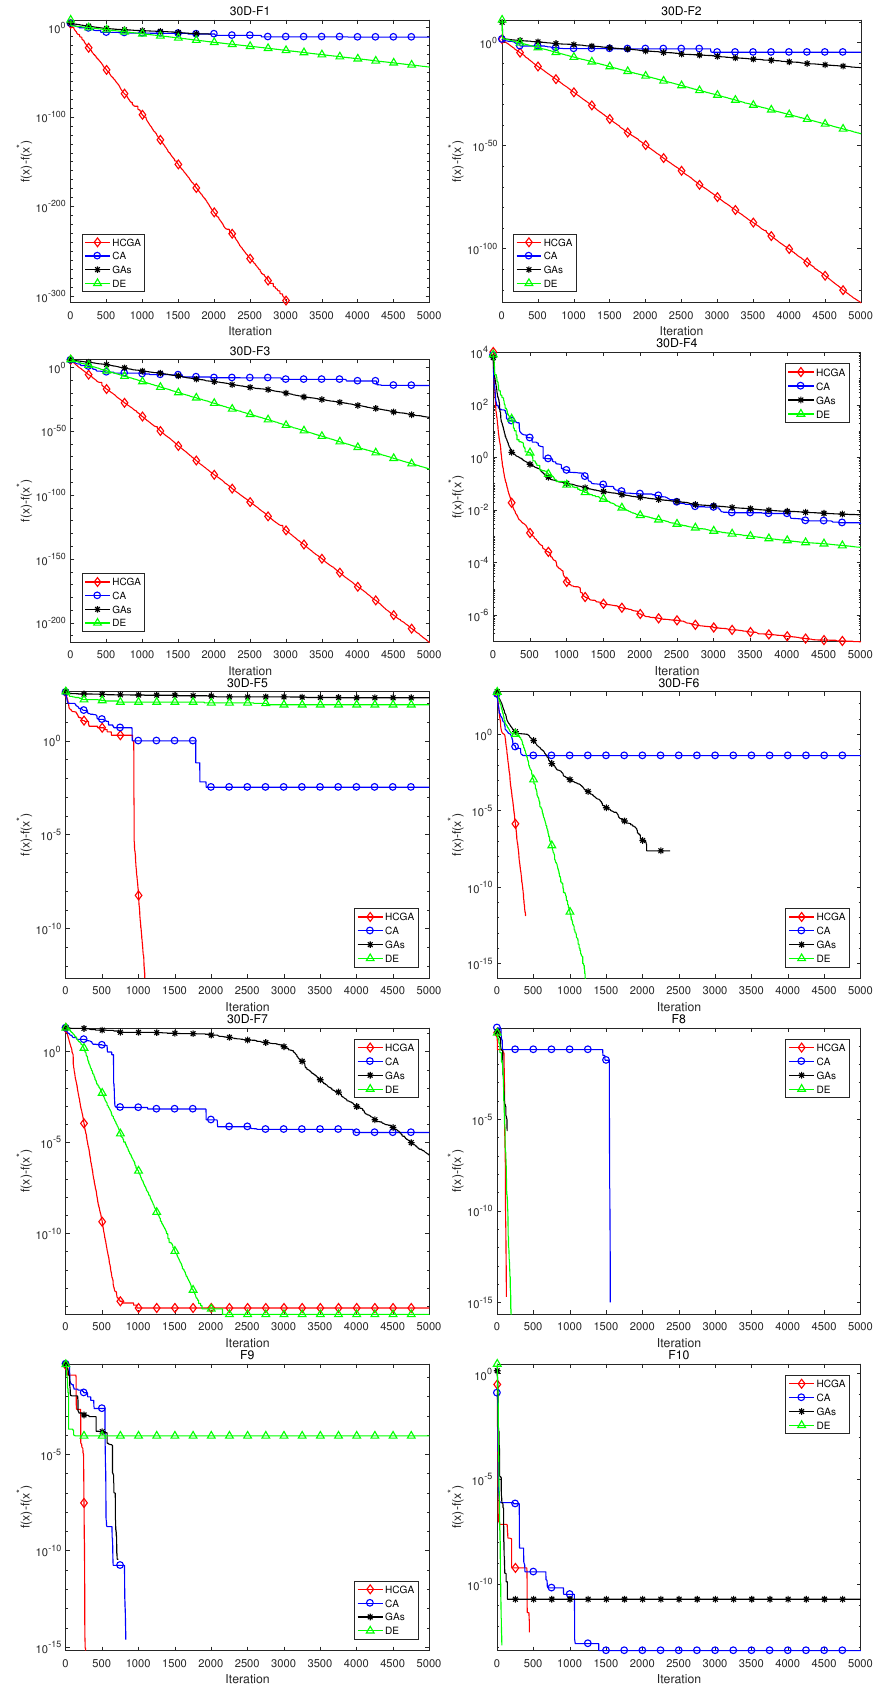
Figure 6. Convergence curves of the test